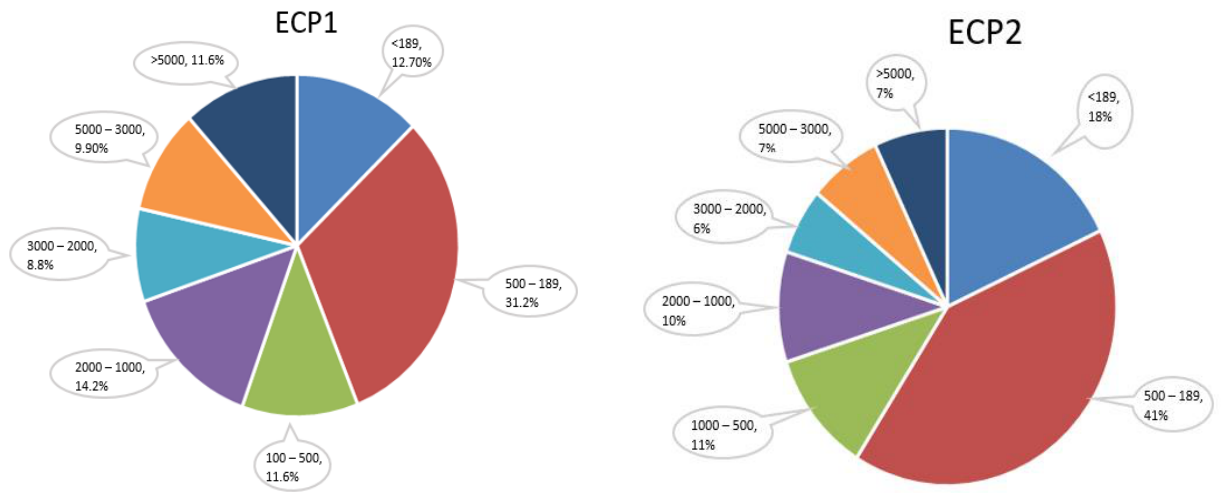
Figure 7. Distribution of molecular weight of small peptides in the raw ingredients of ECP1 and ECP2.